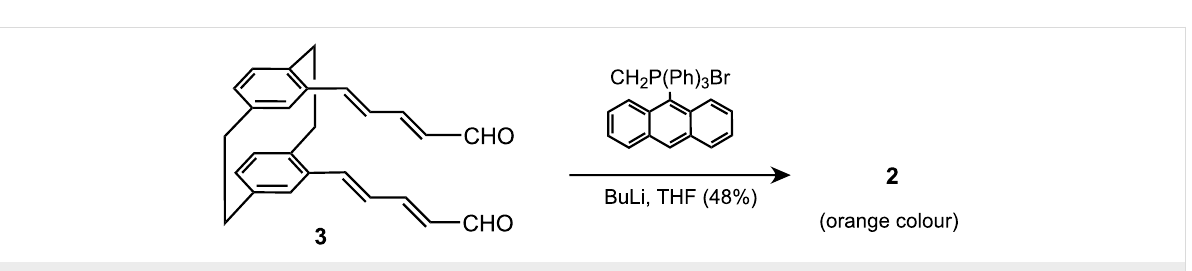
Scheme 1: Preparation of 2 (last step), using the Wittig reaction. The preparation of 3 has been described in ref [19].